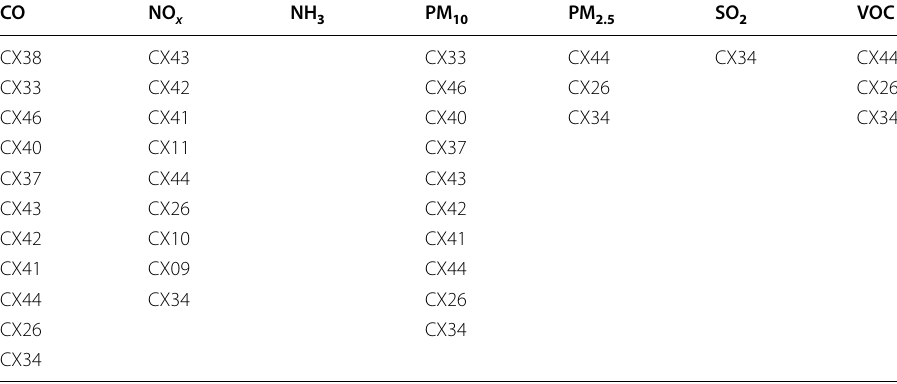
Table 6 Emission inventory decomposition in 2050: sectors for a dominant production effect